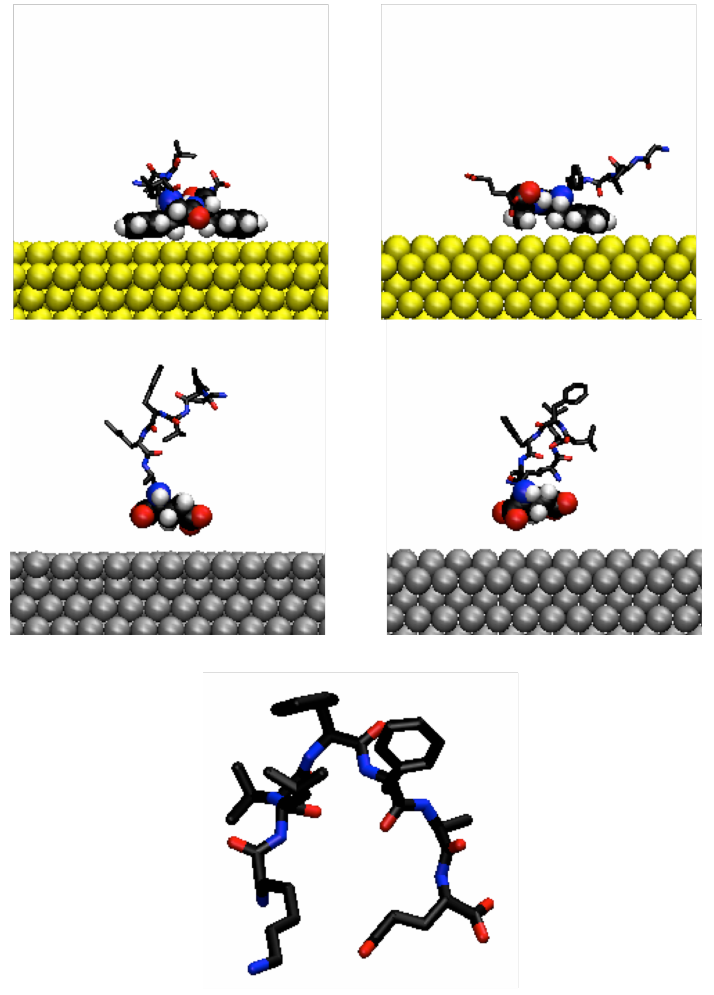
Figure 3. Snapshots showing typical adsorbed conformations for A β (16–22) on Au111 ( top left ), Au100 ( top right ), Ag111( middle left ), and Ag100 ( middle right ) surfaces and typical conformation in bulk solution ( bottom ). Gold and silver spheres show locations of metal atoms. For the surface simulations, residues in contact with the surface are shown as spheres. These are F19 and F20 (Au111), F20 and A21 (Au100), E22 (Ag111), and E22